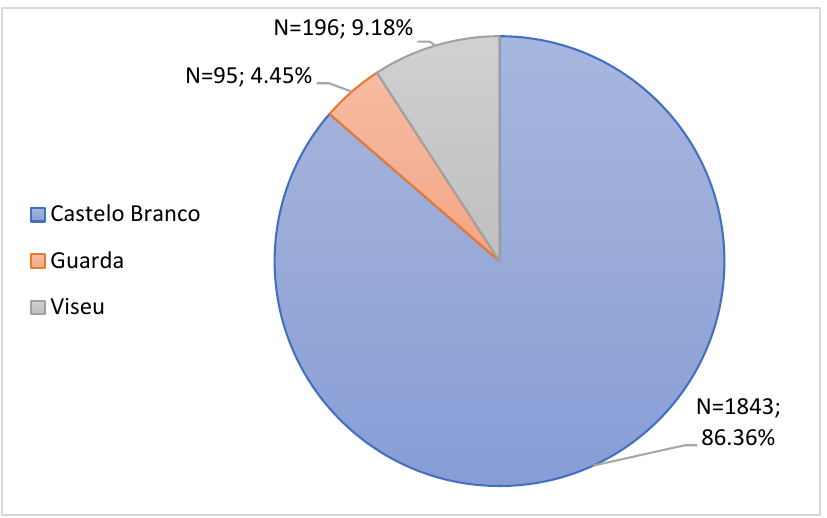
Figure 2. Characterization of notifications by District of Origin of notification.